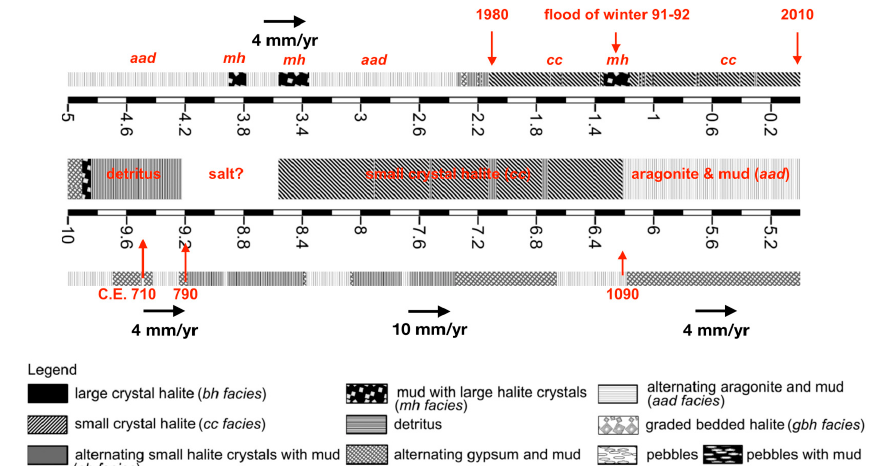
Figure A1. Stratigraphy of the upper sections of the Dead Sea deep sediment core recovered in the winter of 2010–2011 (see reference [4]). The segment shown here is part of the full core stratigraphy presented in Reference [103]. The different types of core facies are shown in the legend. To find the dates of the drought-related salt layer, between the depth of 9.2 m and 6.2 m, we use the nearest 14 C dated location, at a depth of 9.49 m (marked by the arrow). This depth location